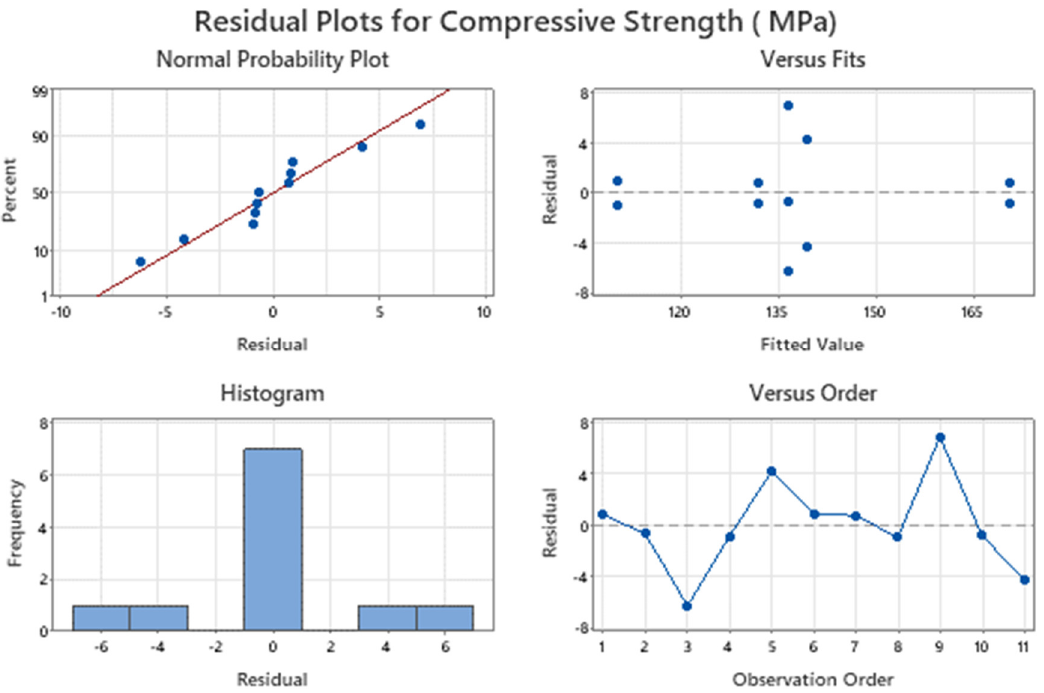
Figure 3. Residual plot of compressive strength.